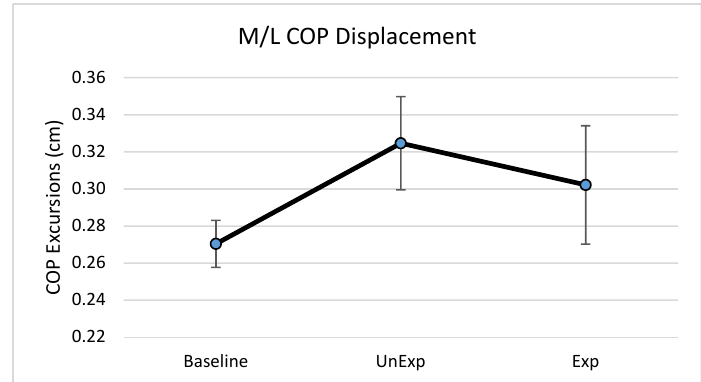
Figure 4. Center of pressure (COP) medial–lateral excursions (cm) during baseline, unexpected (UnExp) moving wall, and expected (Exp) moving wall conditions. Bars represent standard errors.